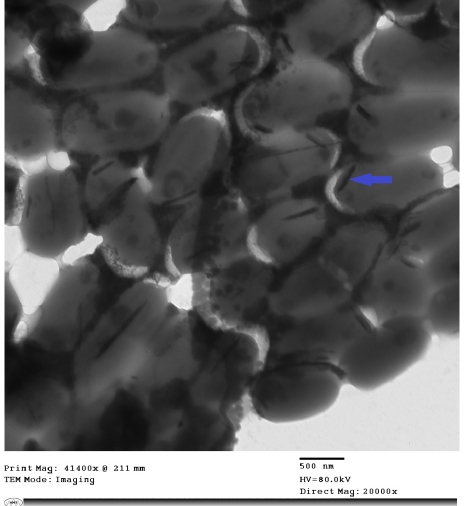
Figure 1. TEM micrograph showing intracellular formation of nanorods by Gayadomonas sp. TNPM15. The blue arrow indicates the formation of intracellular rod-shaped nanostructure.